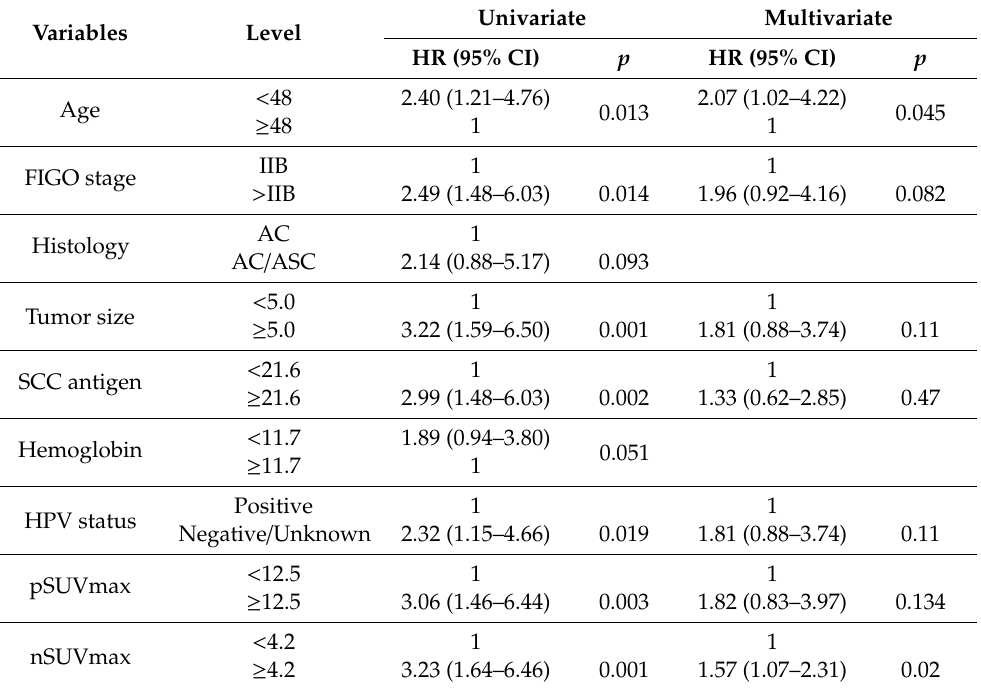
Table 4. Hazard ratio by Cox’s proportional hazards model for risk factors of